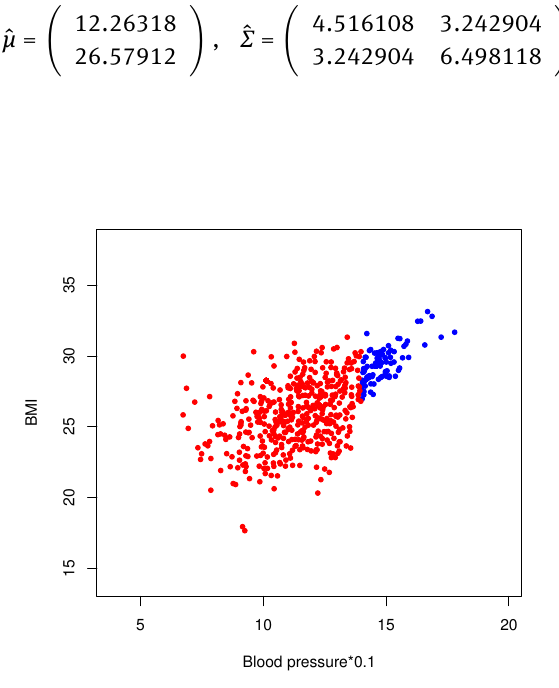
Figure 1: The scatter plot of BMI versus systolic blood pressure, which shows dependency between BMI and blood pressure are differ before and after the